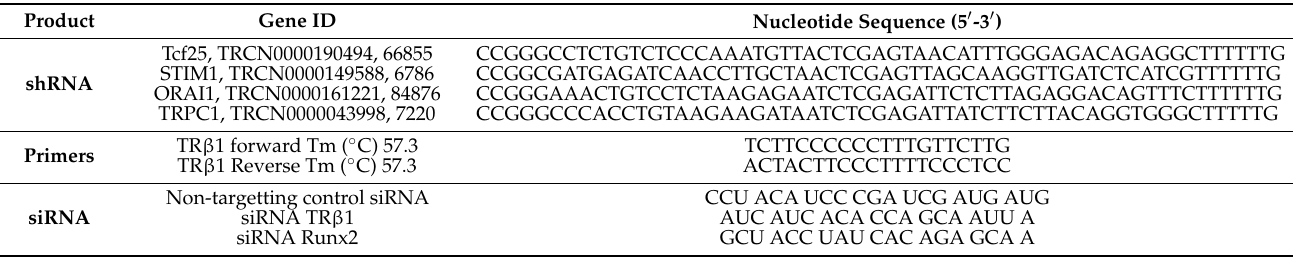
Table 1. shRNA-lentiviral vectors, primers and siRNA